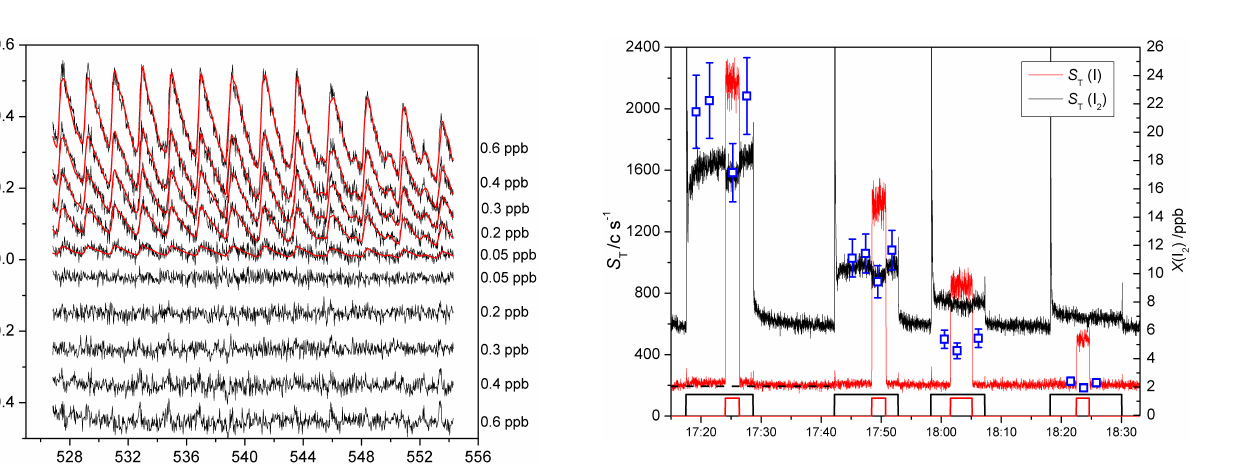
Fig. 7. Calibration raw data. Squared functions indicate direct sam- pling mode (black) and I2 photolysis phase (red). The dashed line helps to visualize the small I 2 fluorescence signal registered by the I atom PCM. Blue squares: I 2 mixing ratios retrieved by IBBCEAS. The spikes at the beginning of the direct sampling mode and I 2 pho- tolysis phase.